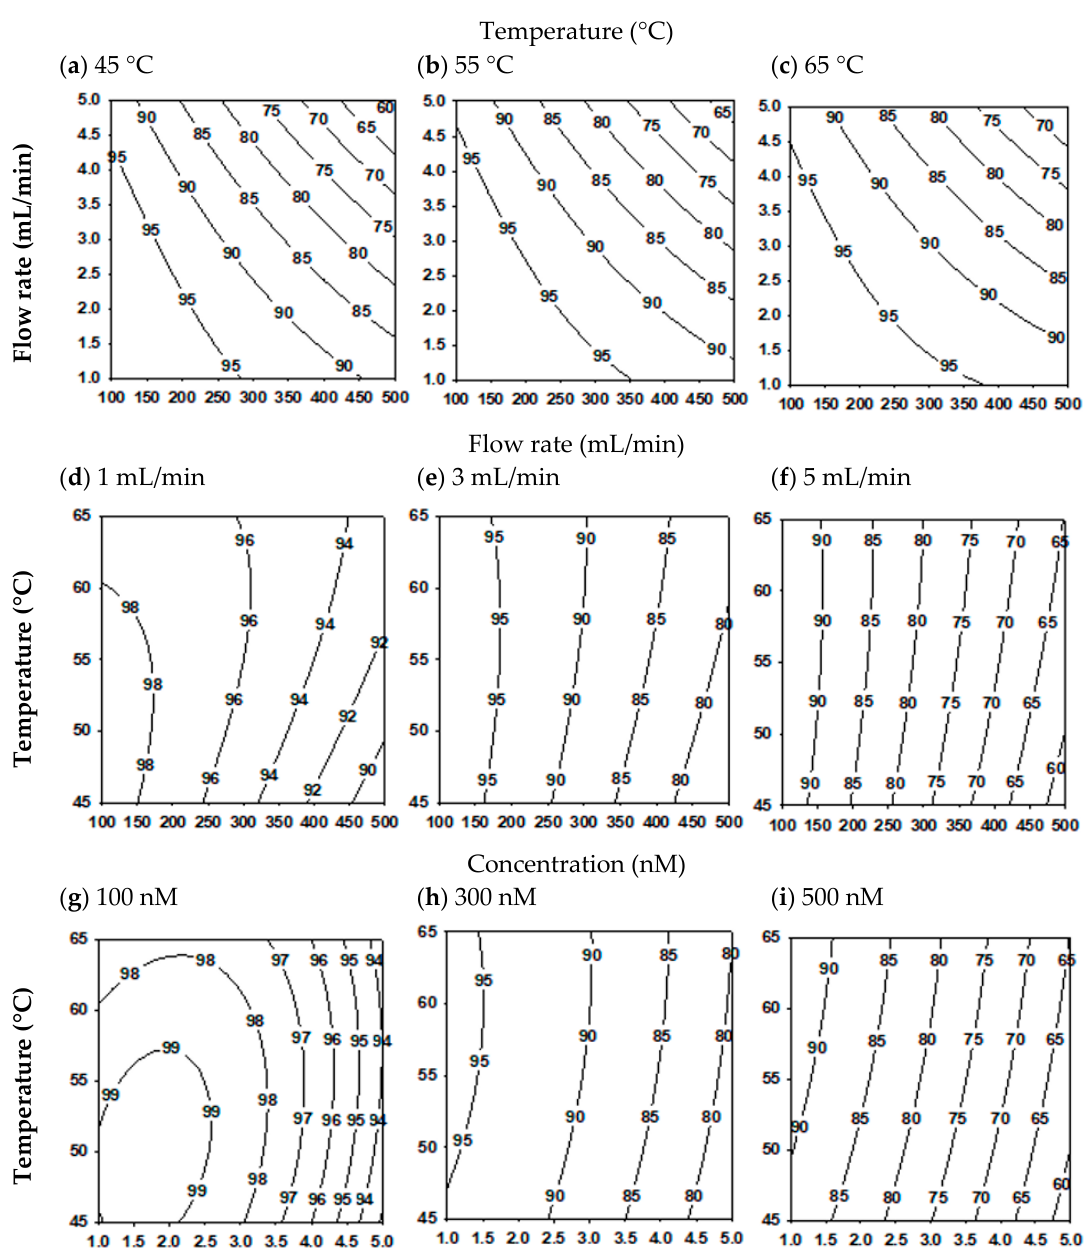
Figure 5. Contour plots show response behavior with varying concentration of 2-PE and flow rate at ( a ) 45 °C, ( b ) 55 °C and ( c ) 65 °C; concentration of 2-PE and temperature at flow rate ( d ) 1 mL min − 1 , ( e ) 3 mL min − 1 and ( f ) 5 mL min − 1 ; flow rate and temperature at ( g ) 100 mM, ( h ) 300 mM and ( i ) 500 mM 2-PE; numbers on contours denote molar conversion of 2-PEAc (%) at given reaction conditions.